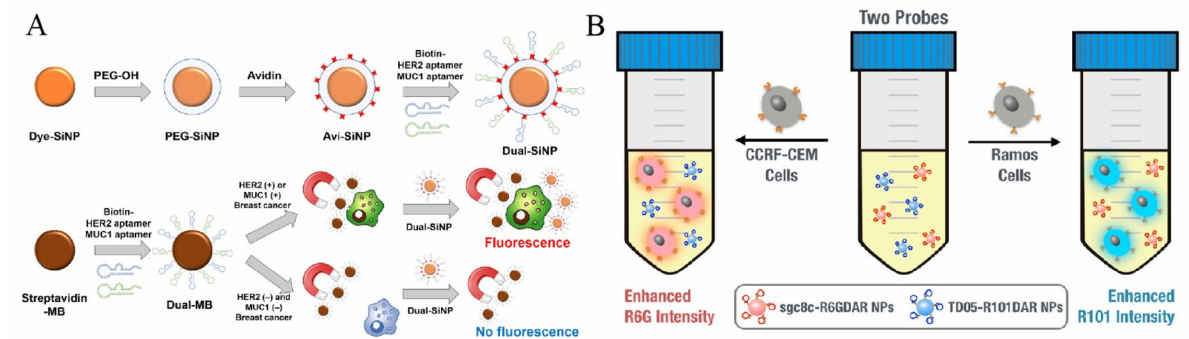
Figure 1. ( A ) Schematic representation of modification processes of dye-SiNPs and the selective detection for only MUC1(+) and HER2(+) breast cancer cells by Dual-SiNPs [68]. Copyright 2015 Elsevier B.V. ( B ) Schematic representation of cell detec- tion/identification using Sgc8c-R6GDAR and TD05-R101DARNPs based on “turn-on” retro-self-quenched fluorescence [70]. Copyright 2015 American Chemical